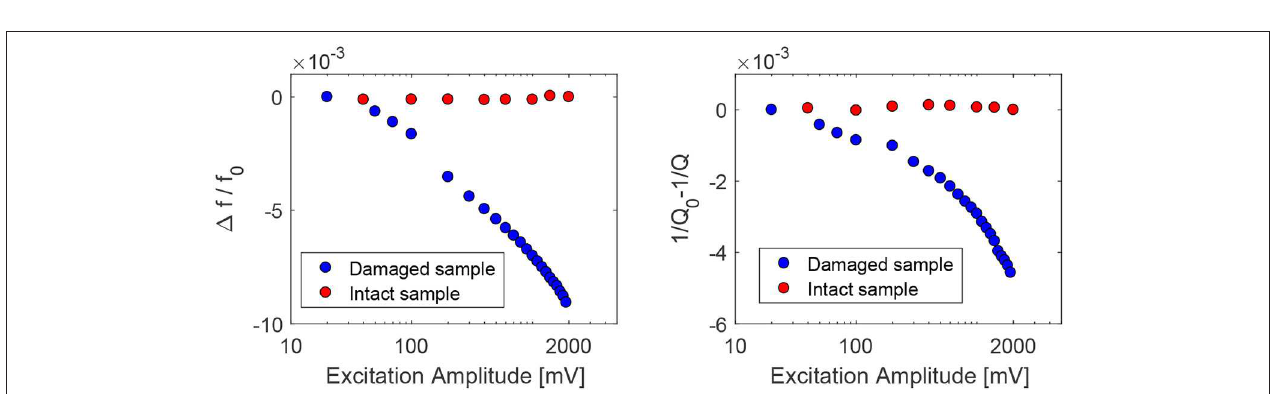
FIGURE 5 | Relative resonance frequency and inverse of quality factor variations as a function of the source amplitude for damaged and intact polymer concrete samples.